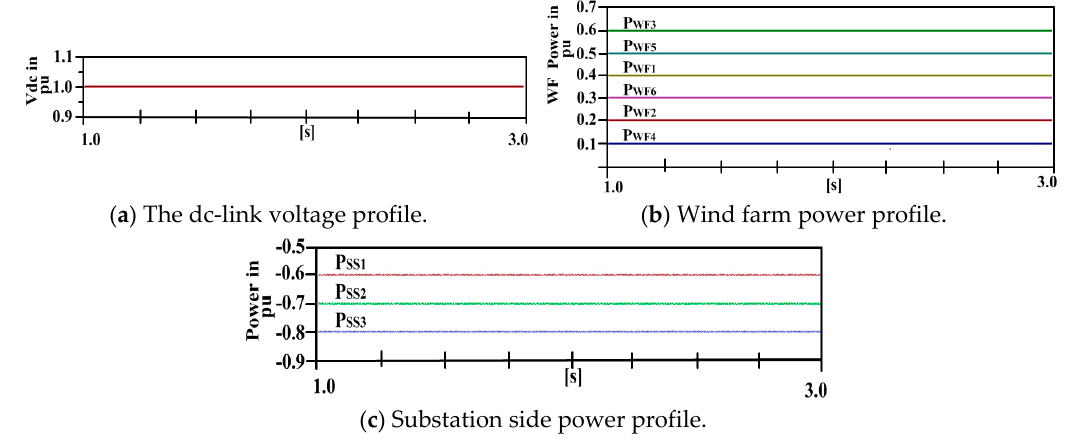
Figure 15. Permanent dc line–line fault F 2 on cable L 13 within substation ring.